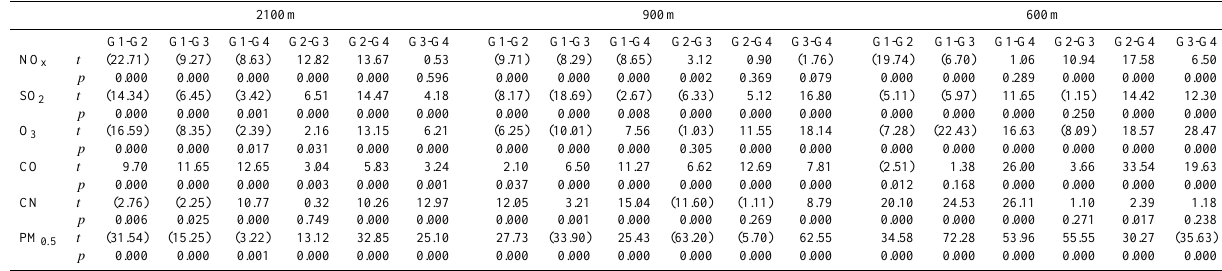
Table 3. Independent t test of gas and particle pollutants at different altitudes between the four groups. 2100m 900m